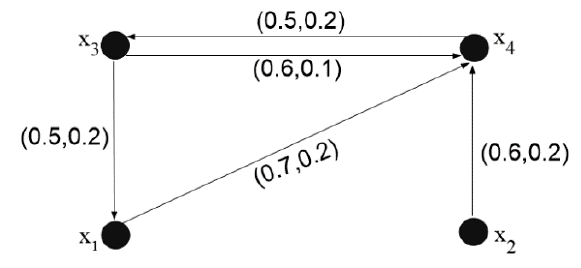
Figure 5. An intuitionistic fuzzy graph.